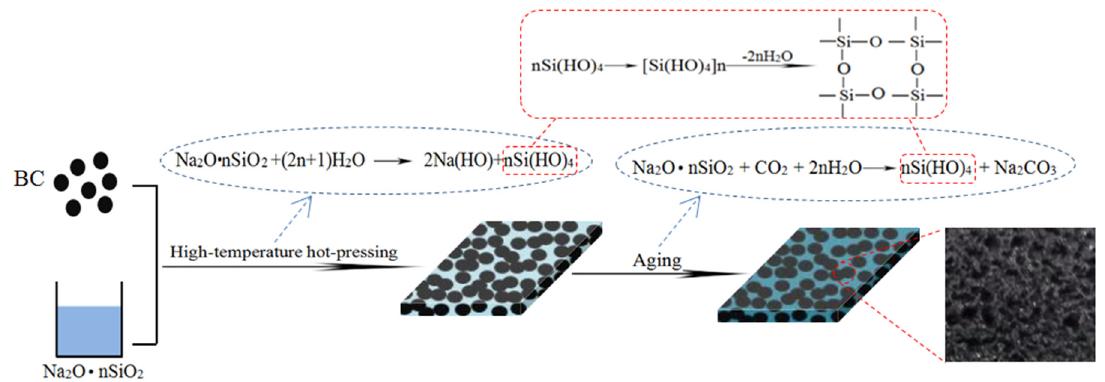
Figure 1. Preparation process and forming mechanism of BC/SS composites.